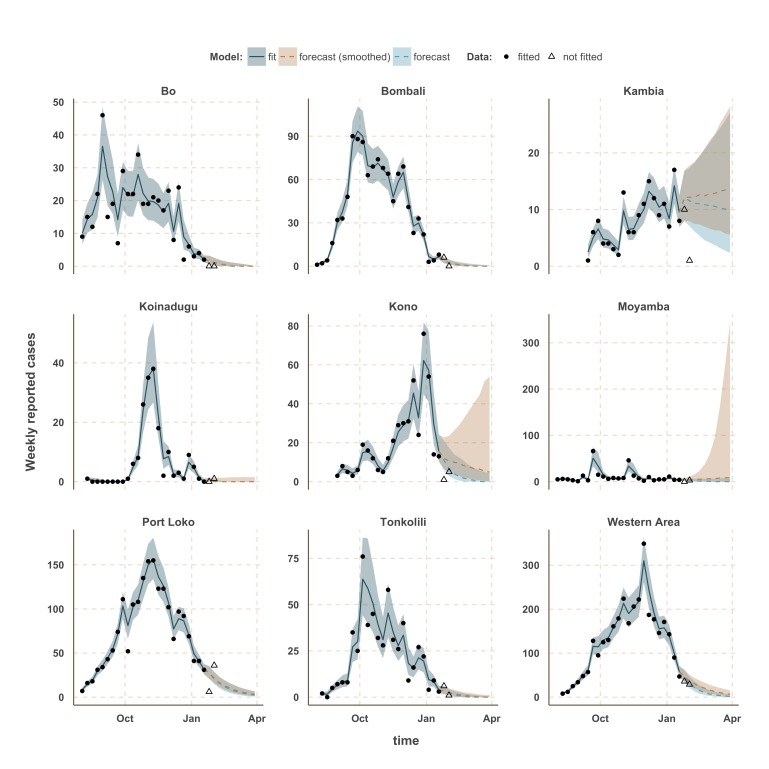
Blue dashed line shows median forecast as in Figures 3-5, with the reproduction number sampled from the posterior at the last data point.Orange dashed line shows median forecast when the reproduction number is sampled from the average posterior distribution over the first three weeks of January. Shaded regions represent interquartile range. Fitted data are plotted as filled circles and the two additional, non-fitted, data as open triangles.